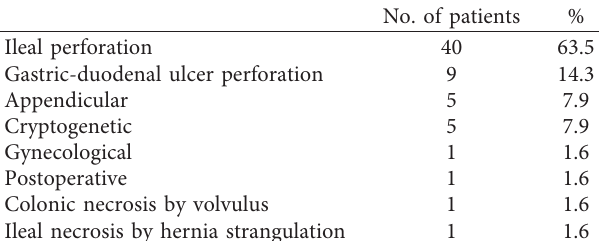
Table 2: Peritonitis